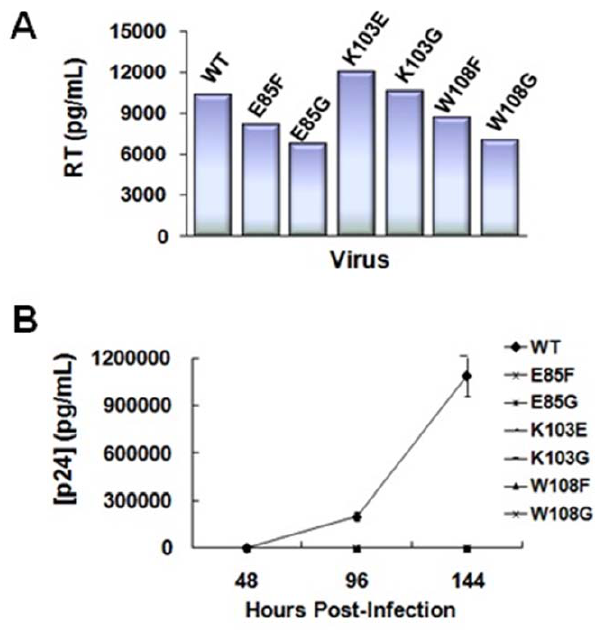
Figure 7. IN dimerization interface mutations inhibit HIV-1 replication after early stage. (A) Exogenous reverse transcriptase activity assay of WT and mutant NL4.3 viruses. (B) Viral breakthrough assay measuring replicative competence over a course of six days. WT virus properly reproduced to reach a p24 measurement of . 1 6 10 6 pg/ mL at the 144 hour time point, while each mutant virus was incompetent for viral replication.